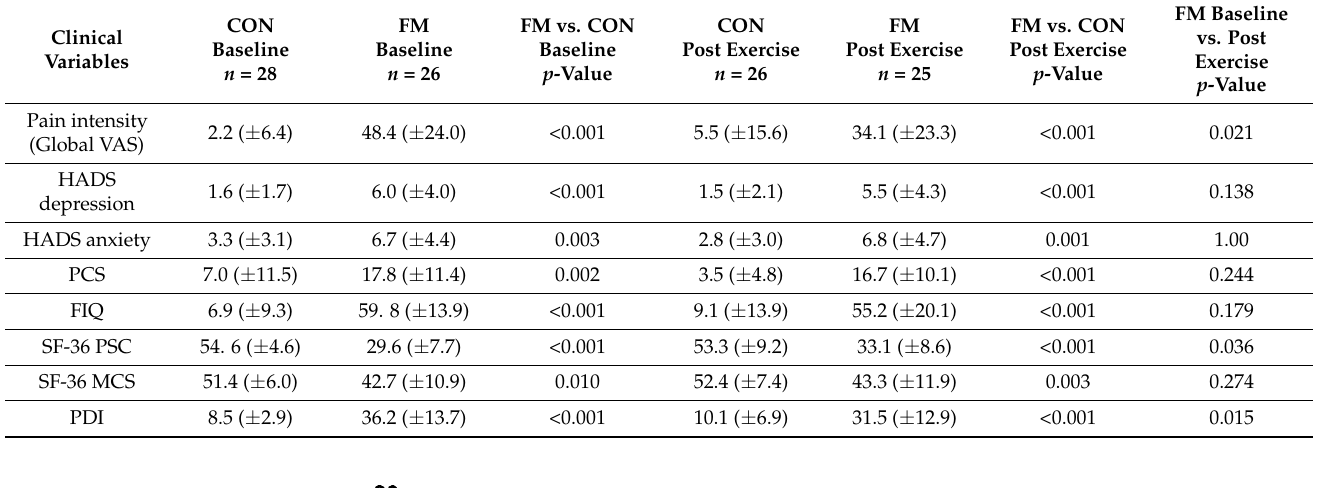
Table 2. Questionnaire data on pain intensity by the Visual Analog Scale (Global VAS), two subscales (anxiety and depression) of the Hospital Anxiety and Depression Scales (HADS), Pain Catastrophiz- ing Scale (PCS), Fibromyalgia Impact Questionnaire (FIQ), Short Form Health Survey 36 (SF-36) with Physical Summary Component measure (PSC) and Mental Component Summary measure (MCS), and Pain Disability Index (PDI). Data are presented as mean and standard deviation ( ± SD). FM = fibromyalgia, CON = healthy controls.